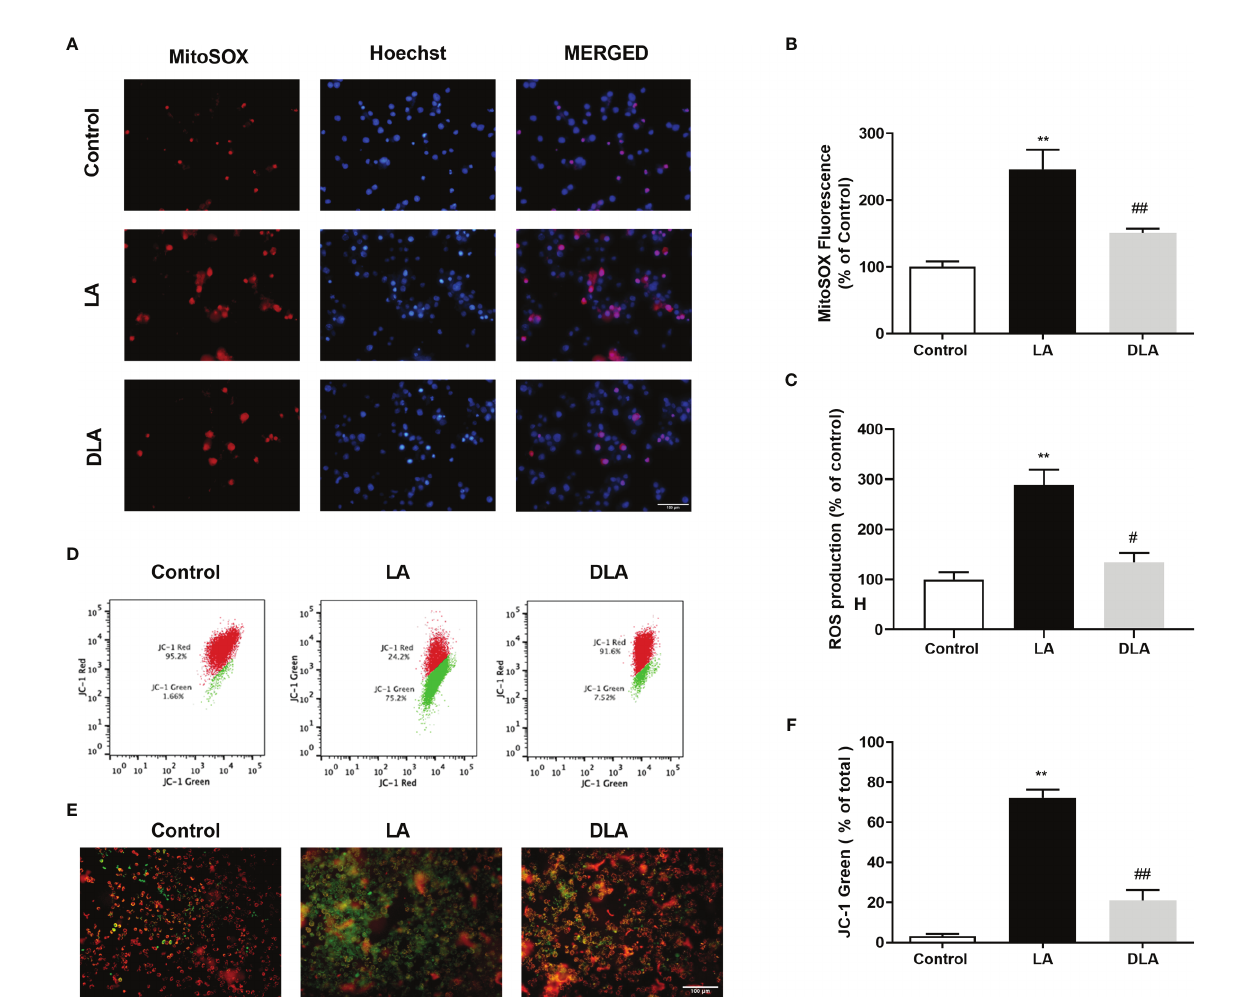
FIGURE 4 | DMF decreased intracellular and mitochondrial ROS formation and restored mitochondrial membrane potential ( DY m). N9 microglia were pretreated with DMF (10 µM) for 1 hour, primed with UP-LPS (1000 ng/ml) for 4 hours, and followed by ATP (5 mM) for 1 hour. The anti-oxidative feature of DMF led to mitigated mitochondrial and intracellular ROS formation and balanced mitochondrial membrane polarization ( DY m). (A, B) The effects of DMF on mitochondrial ROS formation were evaluated with MitoSOX IF staining and MitoSOX fl uorometric assay (Red staining- MitoSOX, Blue staining – Hoechst). (C) The intracellular ROS level was measured with a cellular ROS assay. (D – F) Changes in mitochondrial membrane potential were detected with JC-1 staining via Flow cytometry and IF staining (Red and Green Staining – JC-1). Data are presented as mean ± S.E.M, n = 5. **p < 0.01 compared to control and # p < 0.05, ## p < 0.01 compared to LPS and ATP induced